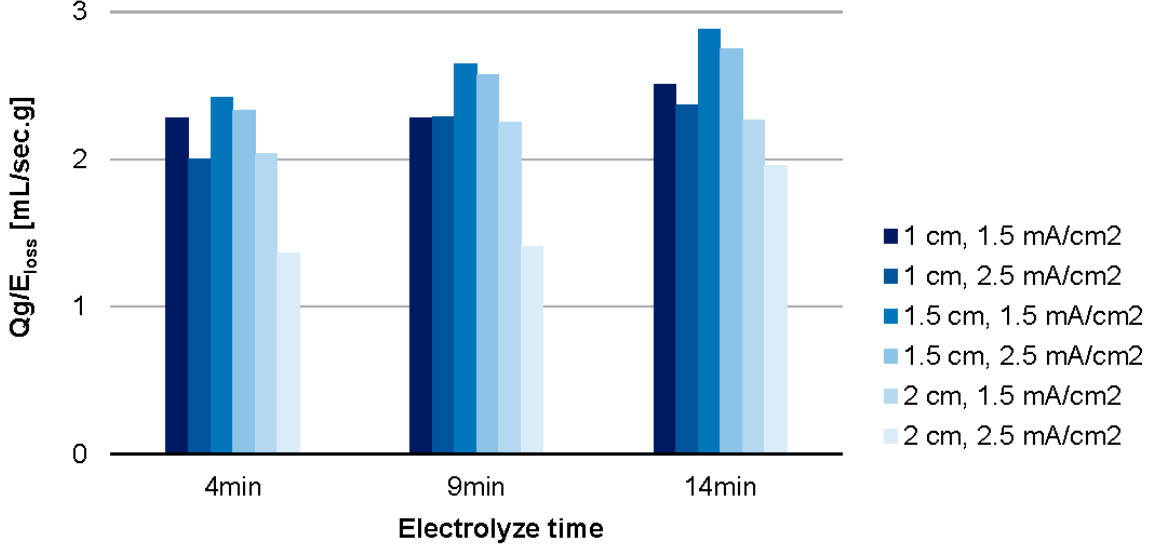
Figure 3. Qg/E loss value at different electrolyze times (4–14 min), electrode gaps (1–2 cm), and current densities (1.5–2.5 mA/cm 2 ).